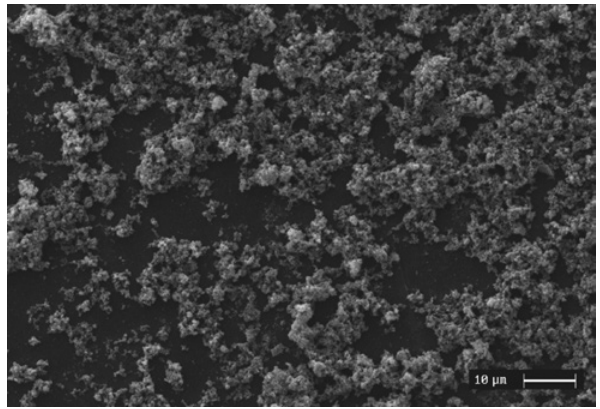
Figure 7: SEM image of Fe nanoparticles.